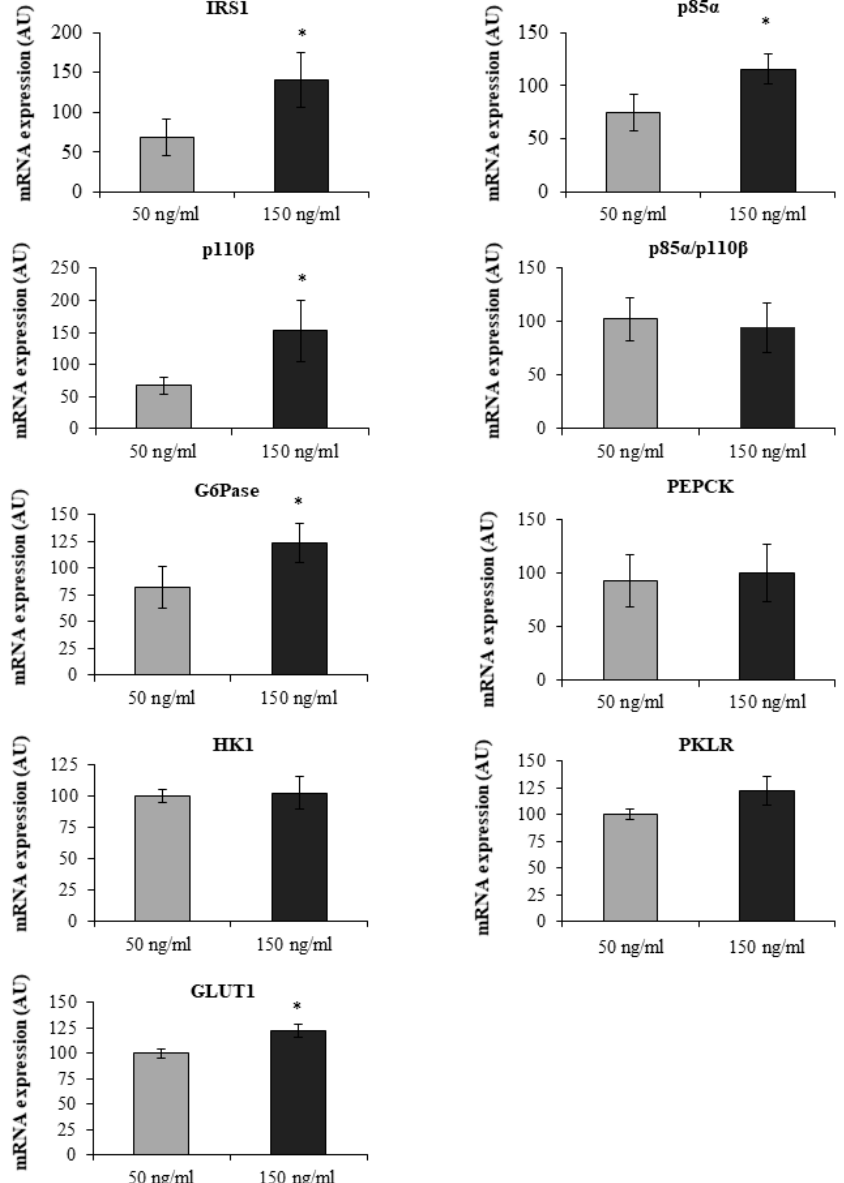
Figure 5. mRNA expression levels of studied genes in intestinal epithelial cells (IEC) incubations obtained from jejunum samples of MO-low-IR ( n = 6). IEC were isolated and incubated as described